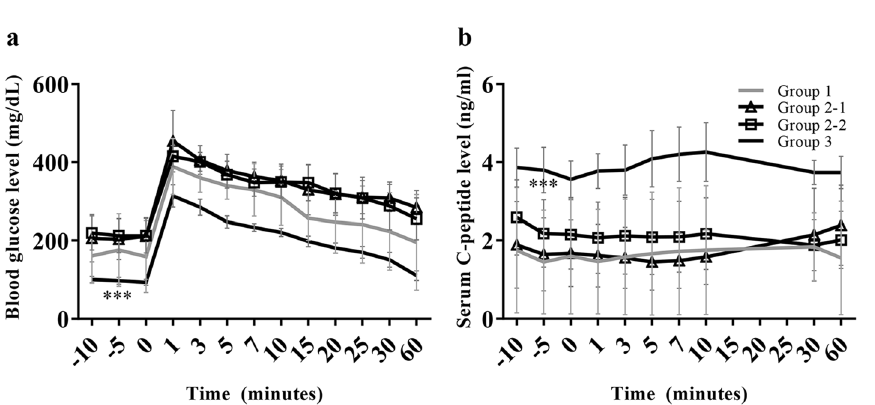
Figure 3. In the group that received a high dose of islets, the transplanted islets maintained their functioning. Intravenous glucose tolerance testing (IVGTT) was conducted one month after transplantation, and the ( a ) blood glucose level and ( b ) serum C-peptide level were analyzed. ( a ) The functioning of the islets in secreting insulin against an increased blood glucose level was the highest in group 3 (N = 4), but groups 1 (N = 2) and 2-1 (N = 2) and 2-2 (N = 3) did not differ from each other. ( b ) Serum C-peptide levels, which are related to insulin secretion, were also significantly higher in group 3 than in groups 1, 2-1 and 2-2. ***p < 0.001. The data are presented as mean ±